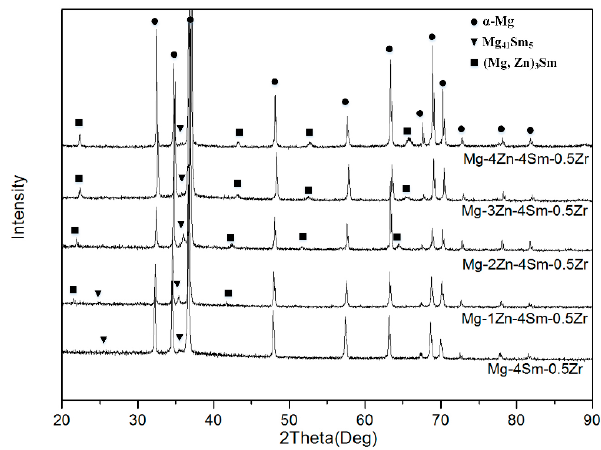
Figure 4. The X-ray diffractometer (XRD) patterns of as-cast Mg–4Sm– x Zn–0.5Zr ( x = 0, 1, 2, 3, 4) (wt %) alloys.